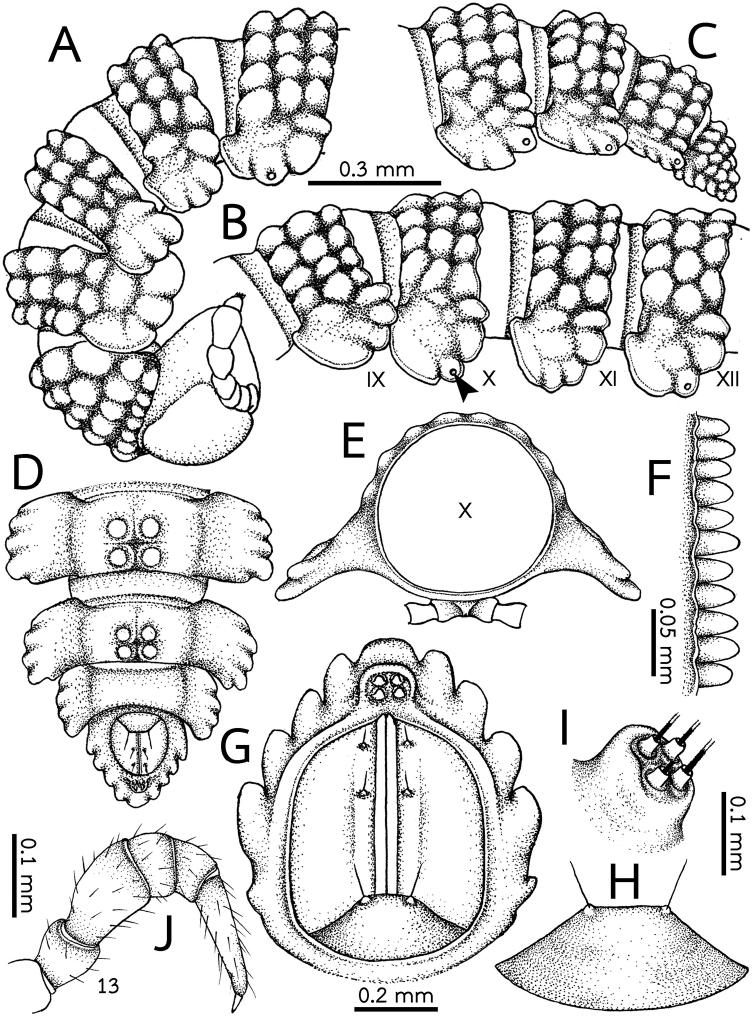
Eutrichodesmus
cambodiensis sp. nov., male paratype (CUMZ–hpd0002) A anterior body part B body rings 9–12 (arrowhead points to ozopore) C, D posteriormost body rings and telson, E mid-body ring F limbus of body ring 10 G last ring and telson H hypoproct I two pairs of apical setae (spinnerets) J leg 13 A–C, I lateral view D, G, H ventral view. Scale bars: 0.5 mm (A–E), 0.1 mm (H, I).